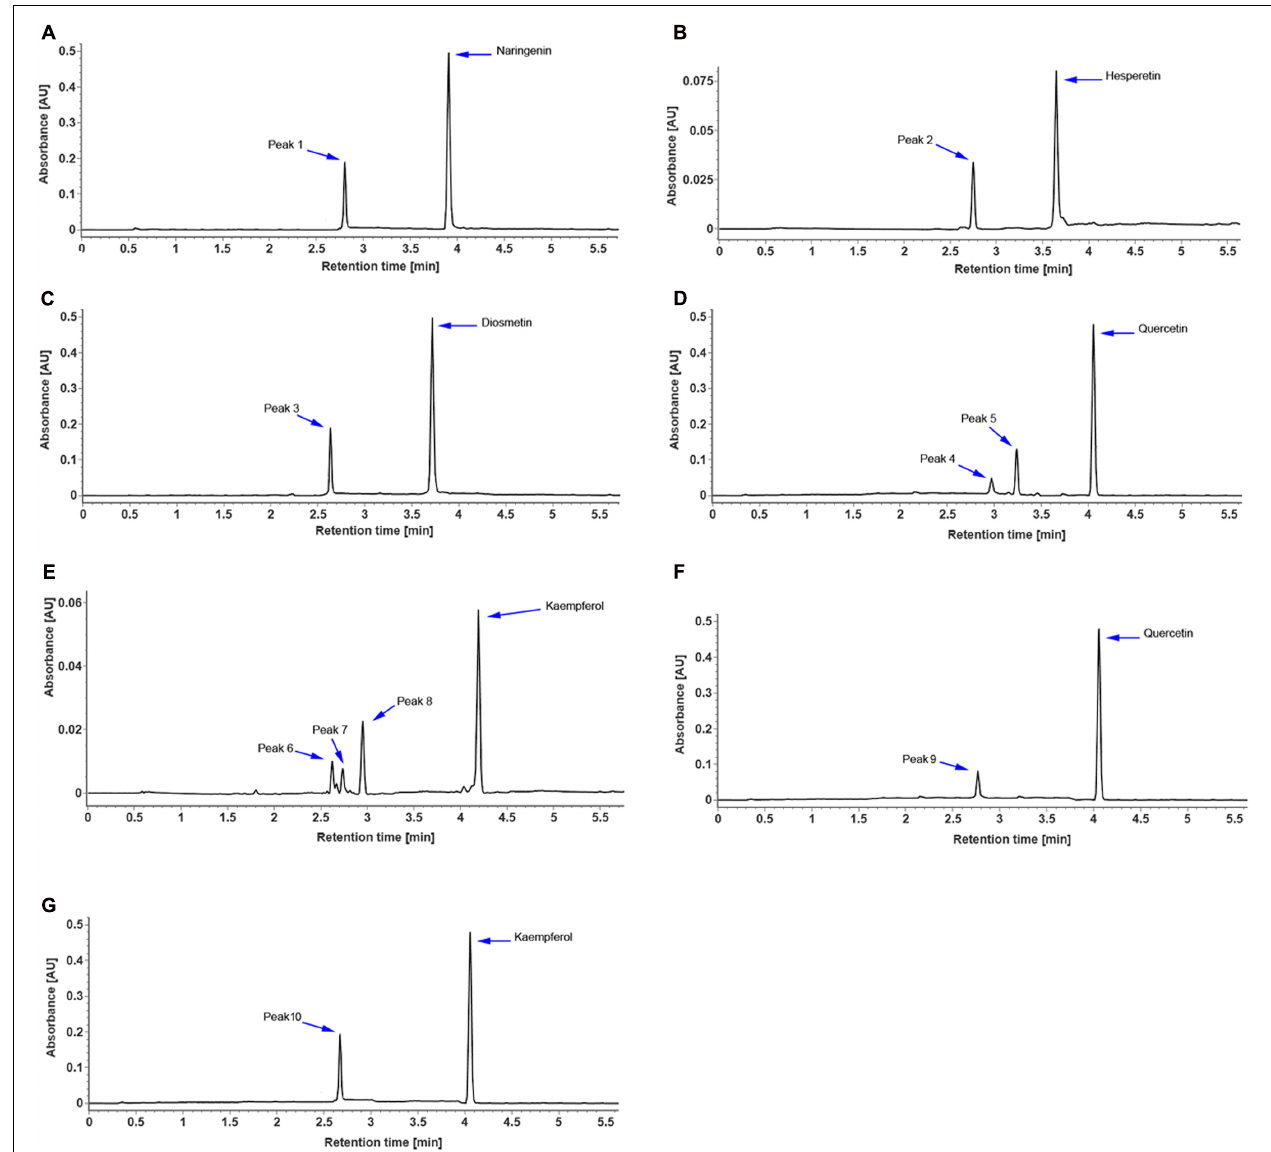
FIGURE 5 | UPLC chromatogram of reaction products of recombinant CsUGT76F1, using UDP-glucose as the sugar donor, toward naringenin (A) , hesperetin (B) , diosmetin (C) , quercetin (D) , and kaempferol (E) , and using UDP-rhamnose as the sugar donor, toward quercetin (F) , and kaempferol (G) . Peaks 1–10 indicate enzymatic products listed in Supplementary Table S3